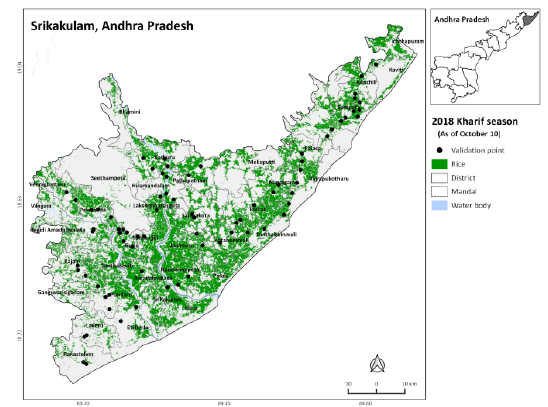
Figure 1. Rice area estimates in Srikakulam district with ground truth validation points, 2018 kharif , 10 October